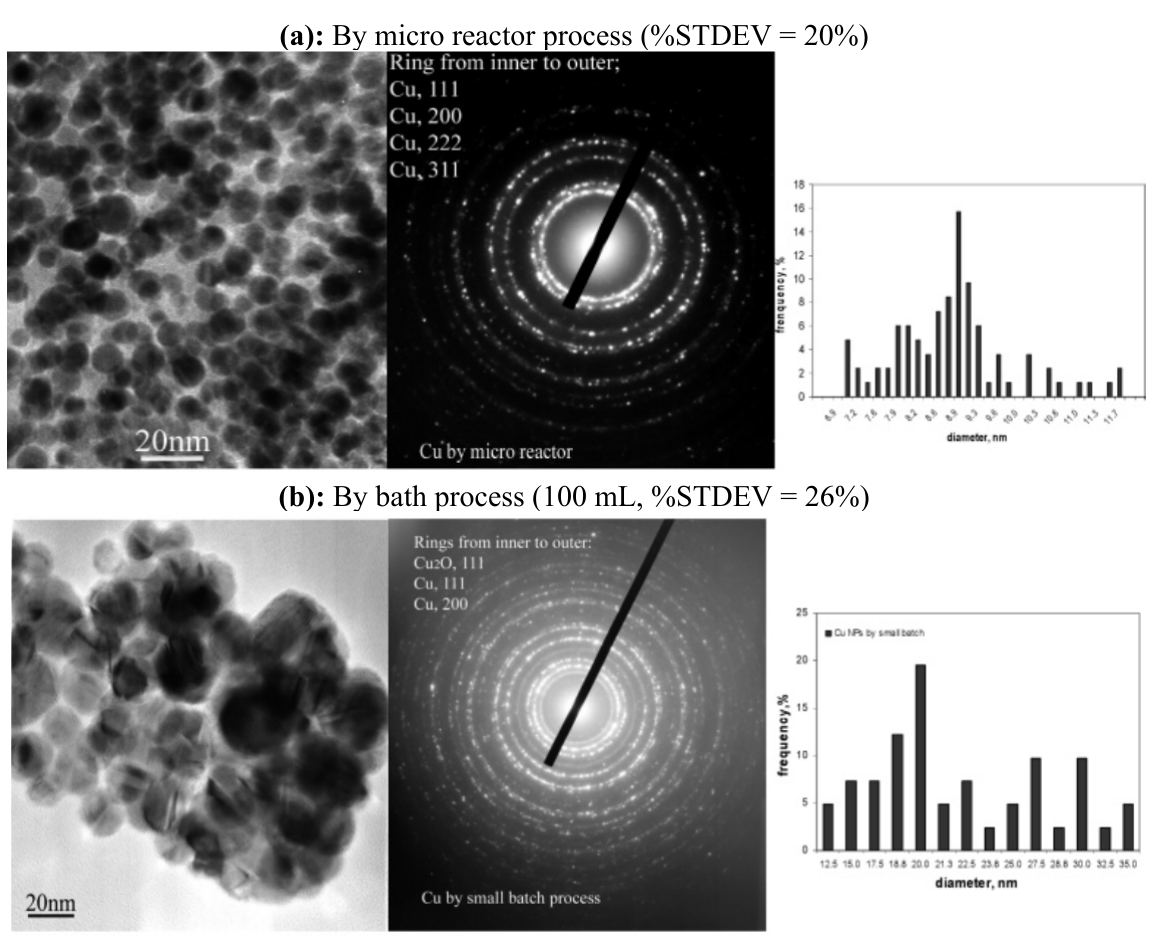
Figure 14. Comparison between the size distribution of copper nanoparticles obtained through the two methods: ( a ) microreactor process and ( b ) batch process